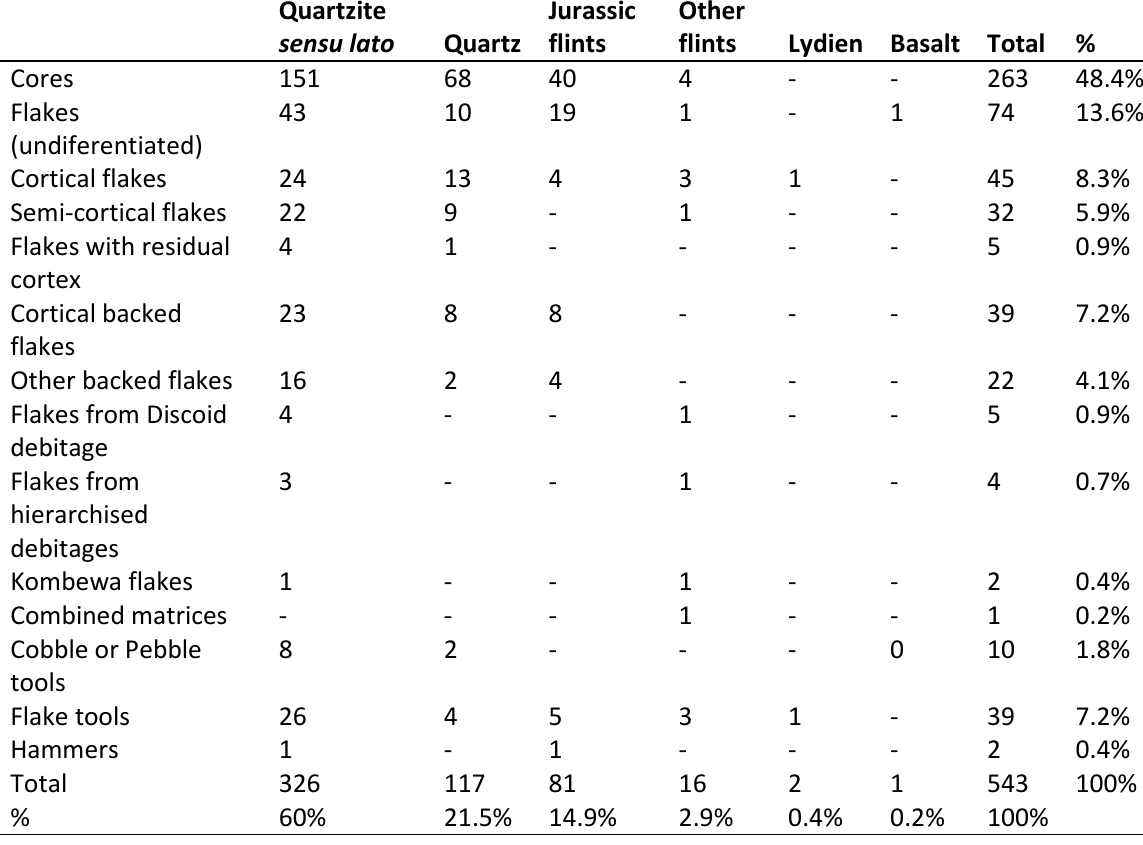
Table 8. Main techno-typological categories in the Camillo lithic industry.